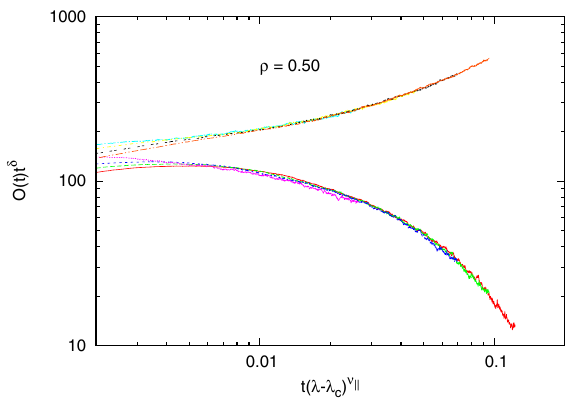
Fig. 6. Variation of average opinion with time at critical points for (cid:1) ¼ 0 : 50 . The value of (cid:7) jj (cid:6) 1 : 40 (cid:5) 0 : 05 Table 1. Comparing the di®erent exponents for di®erent densities. (cid:1)